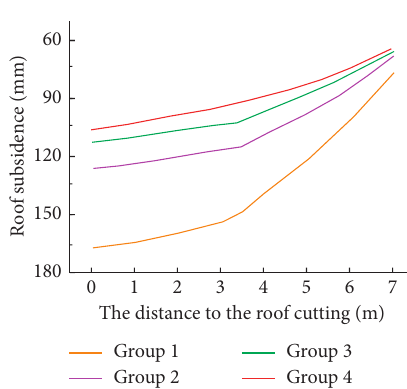
Figure 17: Vertical displacement of